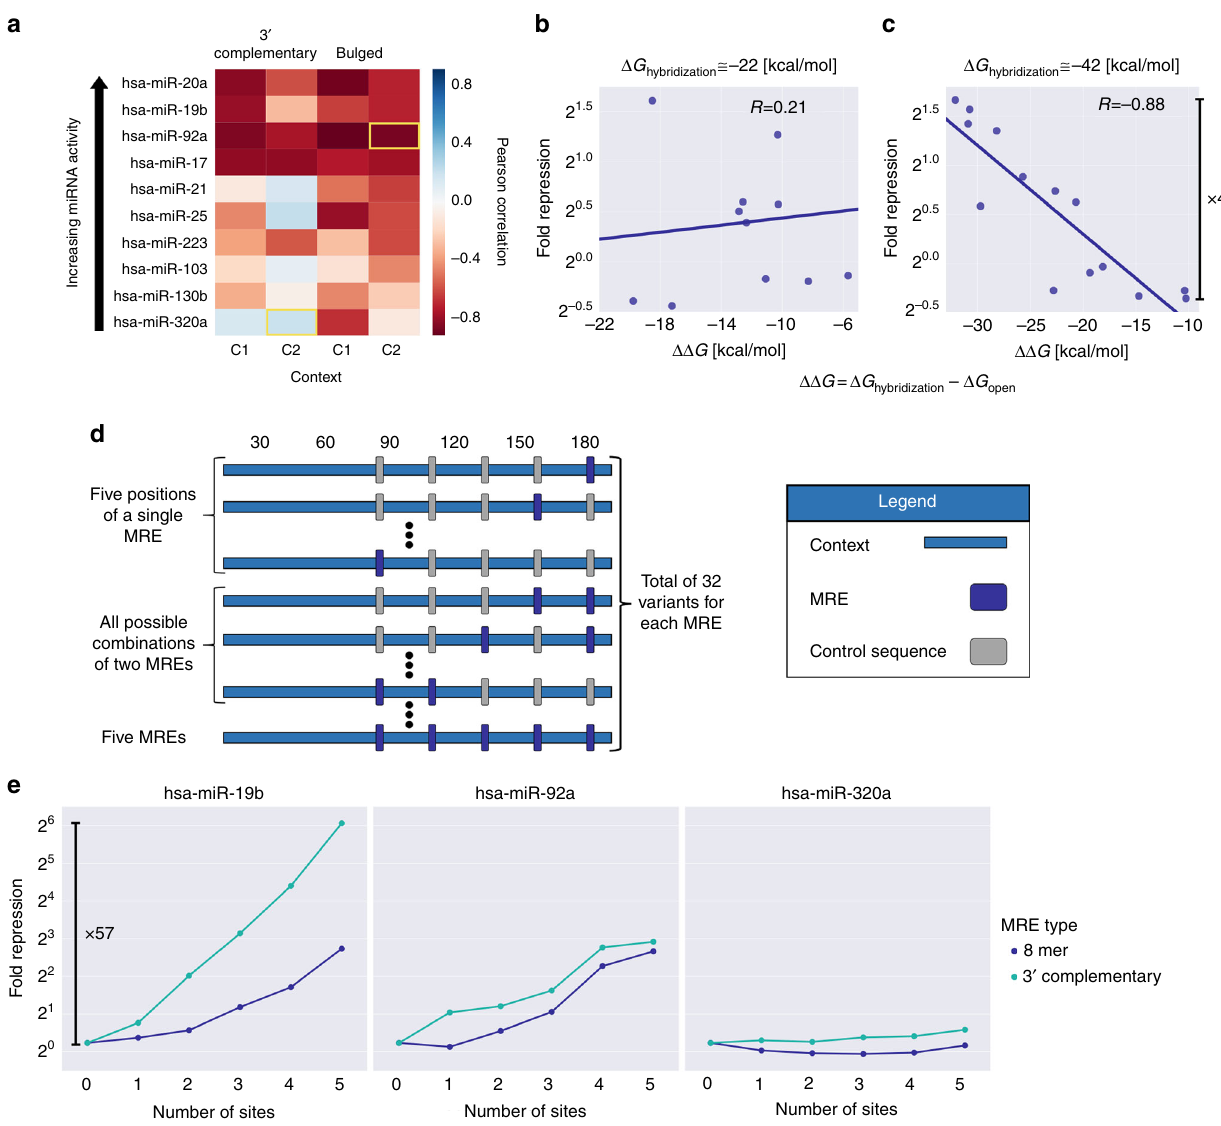
Fig. 4 MRE accessibility and multiplicity can have a signi fi cant effect on fold repression. a For each of the ten selected miRNAs, either a 3 ′ complementary or a bulged MRE were placed in one of two contexts. The context was then mutated to vary the MRE accessibility by imposing different secondary structures using ViennaRNA 2.0 60 predictions, resulting in 637 variants with measured repression. The ΔΔ G for each variant is computed as ΔΔ G = Δ G – Δ G Δ G Δ G hybridization open , whereas hybridization is the hybridization energy between the miRNA and the MRE and open is the change in the ensemble free energy required to impose an unpaired MRE (Methods) 18 . The heatmap presents the Pearson correlation between fold repression and ΔΔ G for each MRE in each context. b Scatter plot of fold repression as a function of ΔΔ G for hsa-miR-320a in context C2, highlighted in a . c Scatter plot of fold repression as a function of ΔΔ G for hsa-miR-92a in context C2, highlighted in a . The bar annotates the 4-fold difference in fold repression spanned by the different mutants. d An illustration of the design approach for the MRE multiplicity analysis. Five positions were selected along the context. In each position either an MRE or a control sequence were placed, generating all 32 variants for a given MRE. This design was applied to a 3 ′ complementary and an 8mer MRE type for each miRNA, resulting in 570 unique variants with measured repression. e For each MRE, the variants were aggregated by the number of MRE sites and their median fold repression was plotted as a function of the number of sites. The bar annotates the 57-fold difference in fold repression that can be achieved by varying the MRE multiplicity for a 3 ′ complementary hsa-miR-19b MRE. See also Supplementary Figure